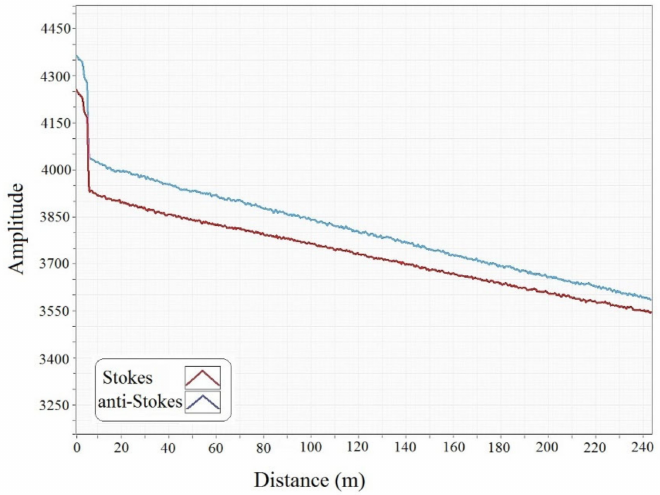
Figure 4. The loss in the intensity of Stokes and anti-Stokes scattering due to the connection of two types of optical fiber